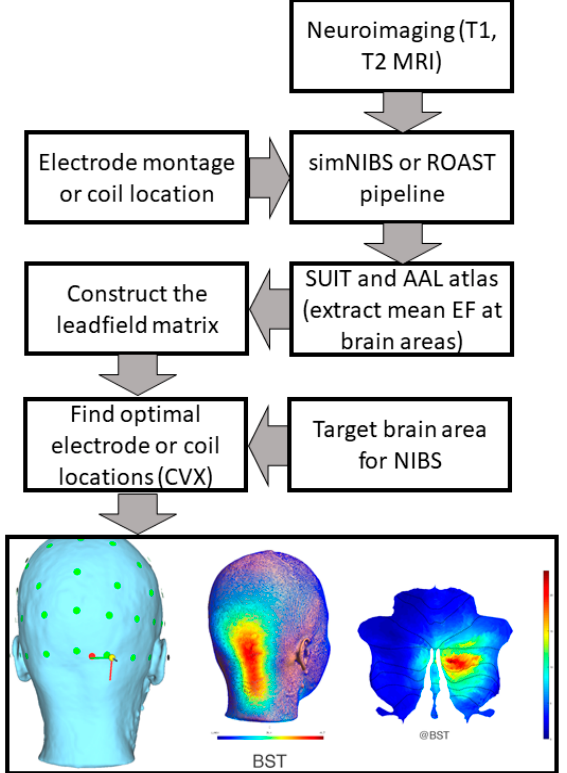
Figure 2. Computational pipeline for MRI-based optimization of non-invasive brain stimulation for a target electric field (EF) distribution using convex optimization (CVX). Bottom panel shows an illustrative example of TMS targeting Crus II at brainstem threshold (@BST).